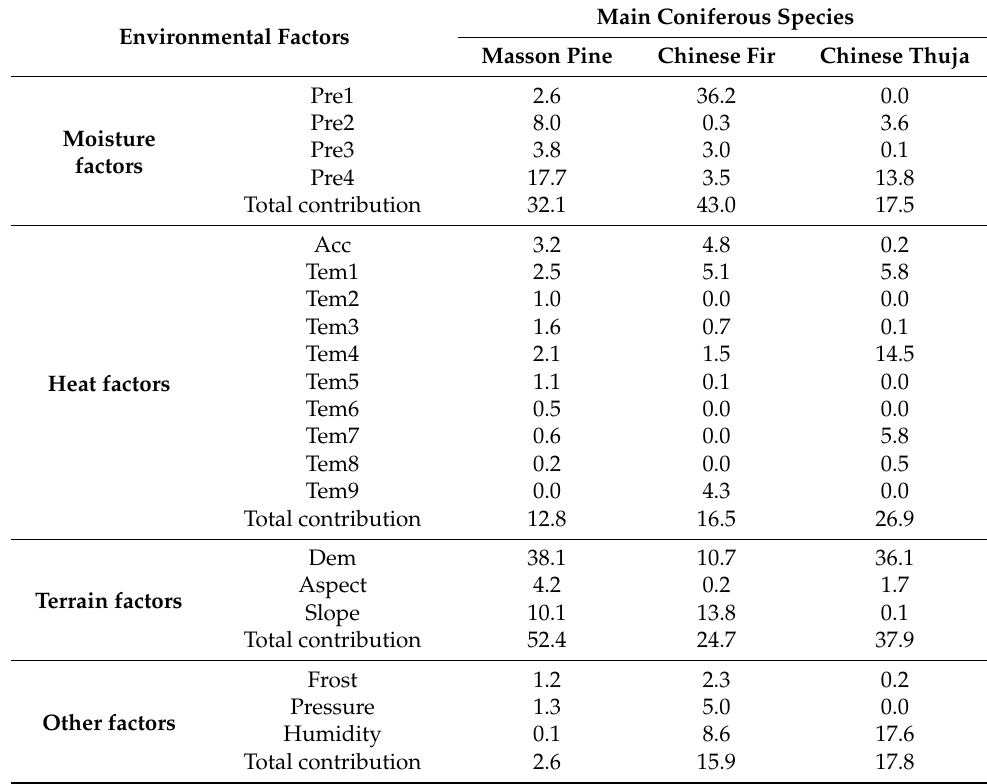
Table 3. Spatial factor contribution rate analysis table.